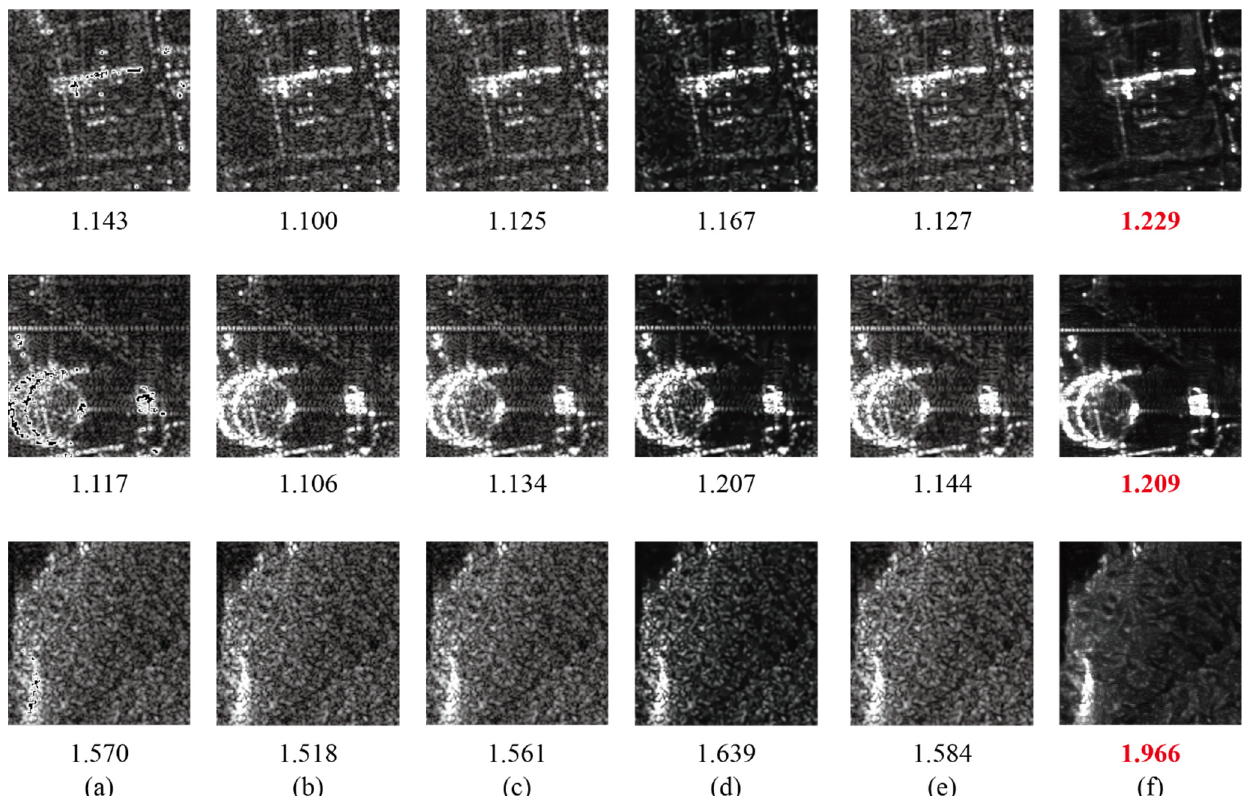
Figure 8. The despeckling results of different despeckling methods. ( a ) Kuan. ( b ) NLM ( c ) Frost. ( d ) DnCNN. ( e ) SAR-BM3D. ( f ) The proposed method. The scores below the images are ENLs. The red bold format represents the best scores.